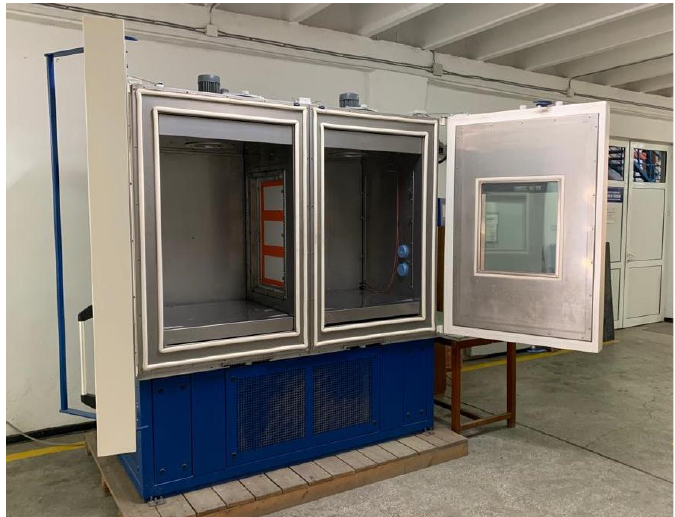
Figure 3. Test panel mounted as a partition.